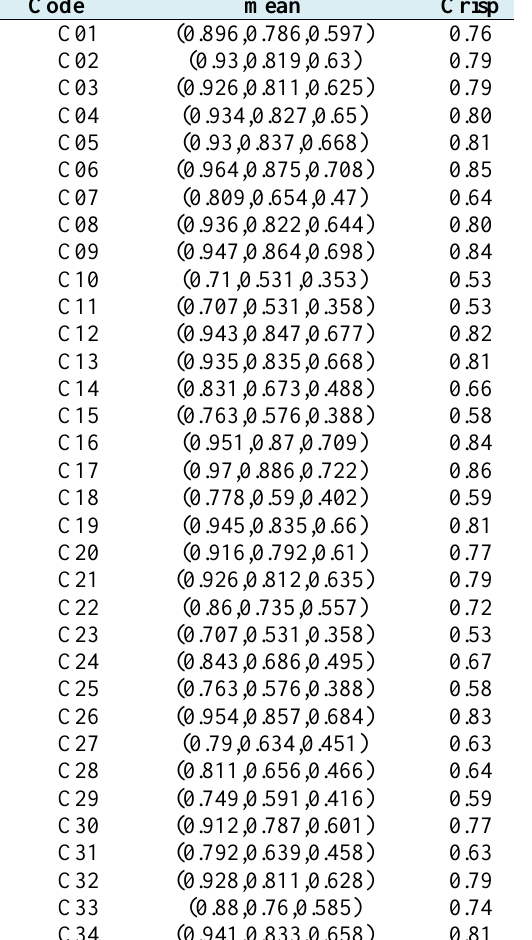
Table 6. Determining the definite value of each indicator Code